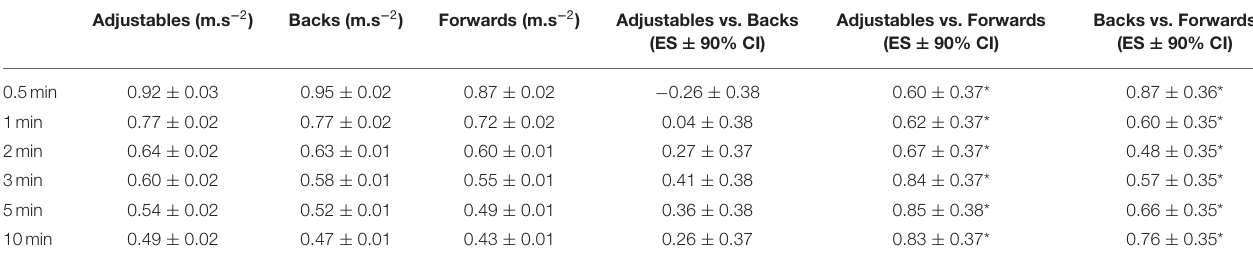
TABLE 2 | Average acceleration/deceleration